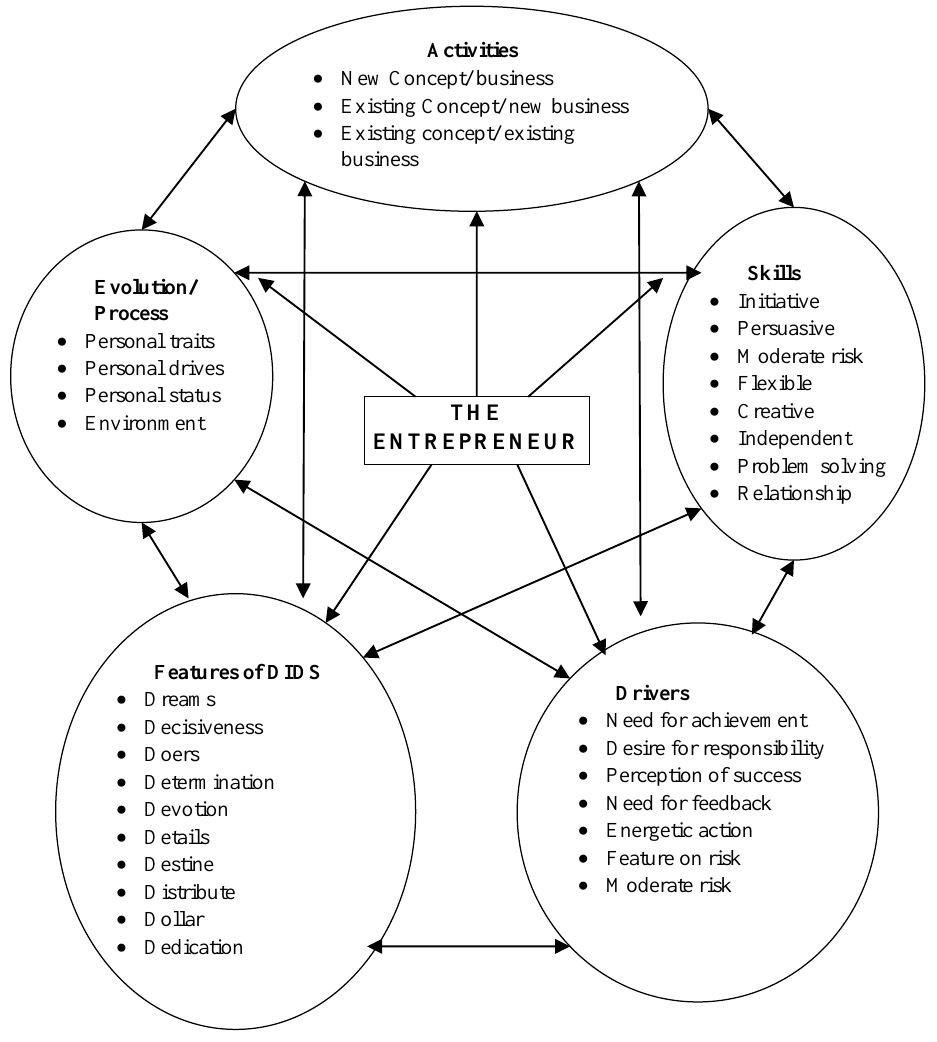
Fig. 1. Entrepreneurship and environment (Ogundele & Opeifa,